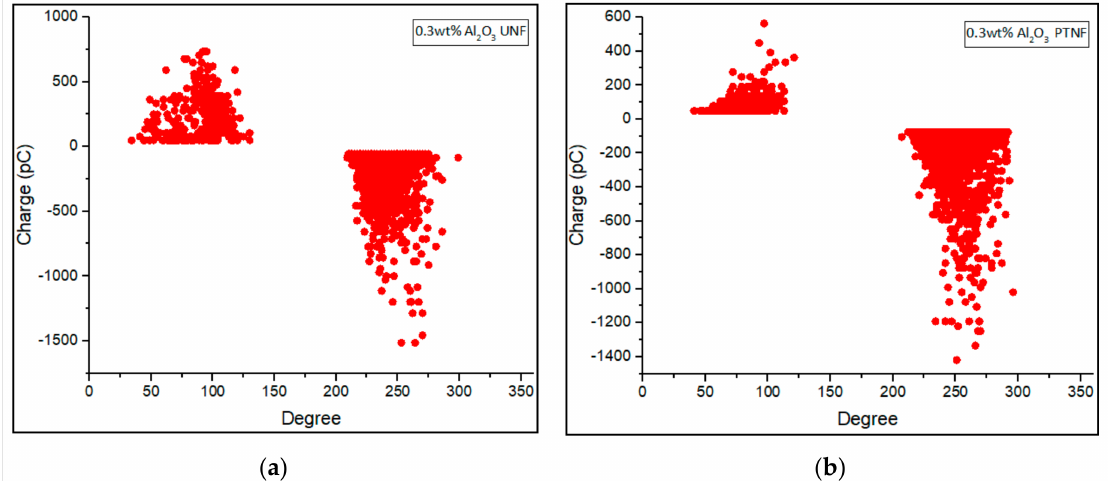
Figure 11. Phase—resolved PD patterns of ( a ) 0.3 wt% Al 2 O 3 UNF and ( b ) 0.3 wt% Al 2 O 3